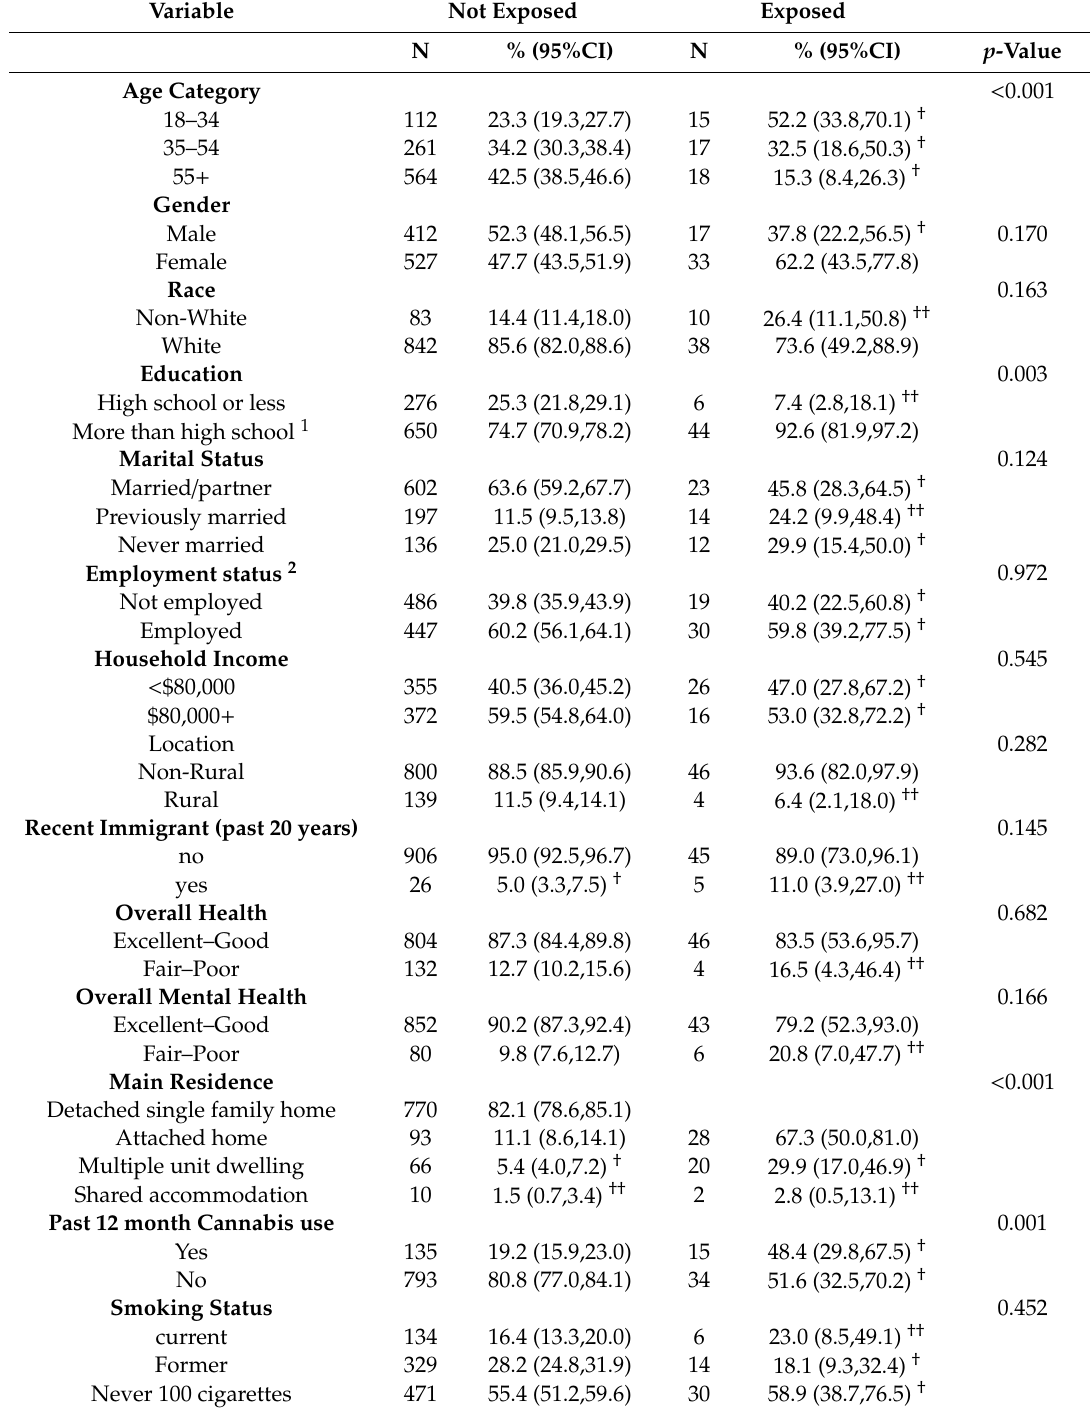
Table 1. Prevalence of Exposure to Environmental Tobacco Smoke, Ontario, Canada, 2017.